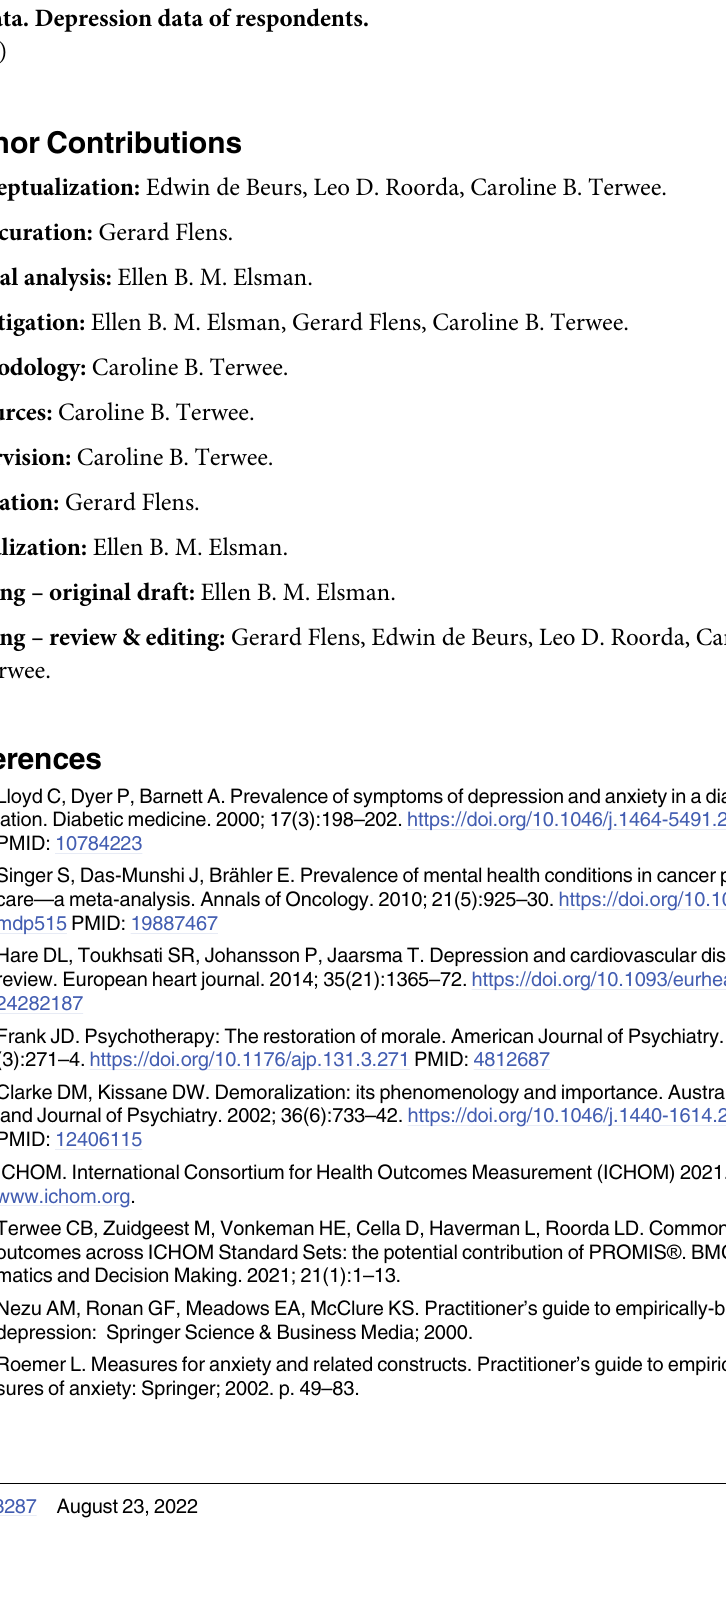
S2 Fig. Relation between T-scores and differences in T-scores original vs. hybrid approach. (TIF) S1 Data. Anxiety data of respondents. (POR) S2 Data. Depression data of respondents.